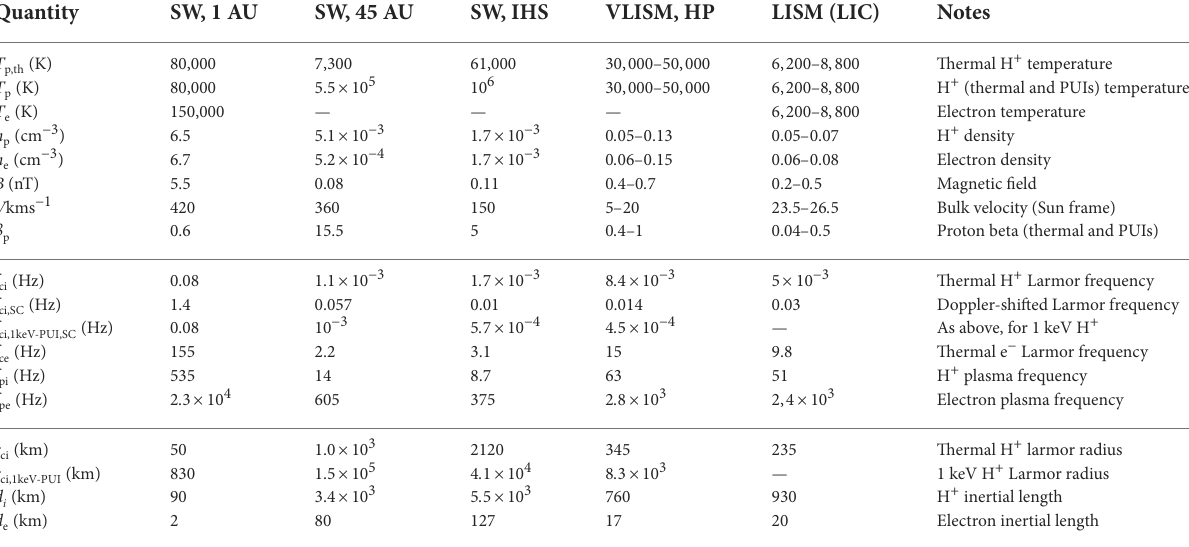
TABLE 1 Typicalplasmaparametersinvariousregionsofspace.Thevaluesat1 AUareaverageSWconditionsintheEclipticfrom2012to2022(OMNIand Winddatahttps://omniweb.gsfc.nasa.gov/).At45 AU,wereporttheSWandPUIobservationsmadeby NewHorizons (McComas et al., 2021),andthe magneticfieldat V2 .IntheIHS,weuseaverage V2 observationsform2008to2018(e.g.,Richardson et al., 2022).SincePUIwerenotmeasuredby Voyager , weassumedthedensityfractionof25%and T PUI = 5 × 10 6 .TherearenoelectronmeasurementsinthedistantSW.IntheVLISMinproximityoftheHP,we showtherangeofvaluesobservedby V1 and V2 (within150 AUfromtheSun).Inparticular,wepresent V1 and V1 magneticfieldobservations(e.g., Burlaga et al., 2022),temperaturemeasuredby V2 (Richardson et al., 2019),electrondensityfrom V1 /PWSobservations(Gurnett et al., 2021),flowspeedfrom simulations(Pogorelov et al., 2017a;Kim et al., 2018).Lastly,abouttheLISMpropertiesintheLIC,weindicatetherangeofvaluesbasedontheextensive literature,see(e.g.,seeSlavin, 2009;Frisch et al., 2011;McComas et al., 2015;Zirnstein et al., 2016;Wood et al., 2019;Linsky et al.,